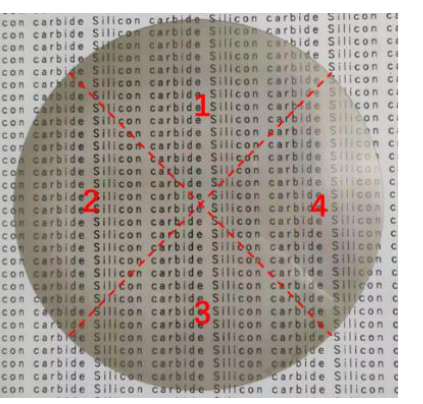
Figure 3. Rheology curves.